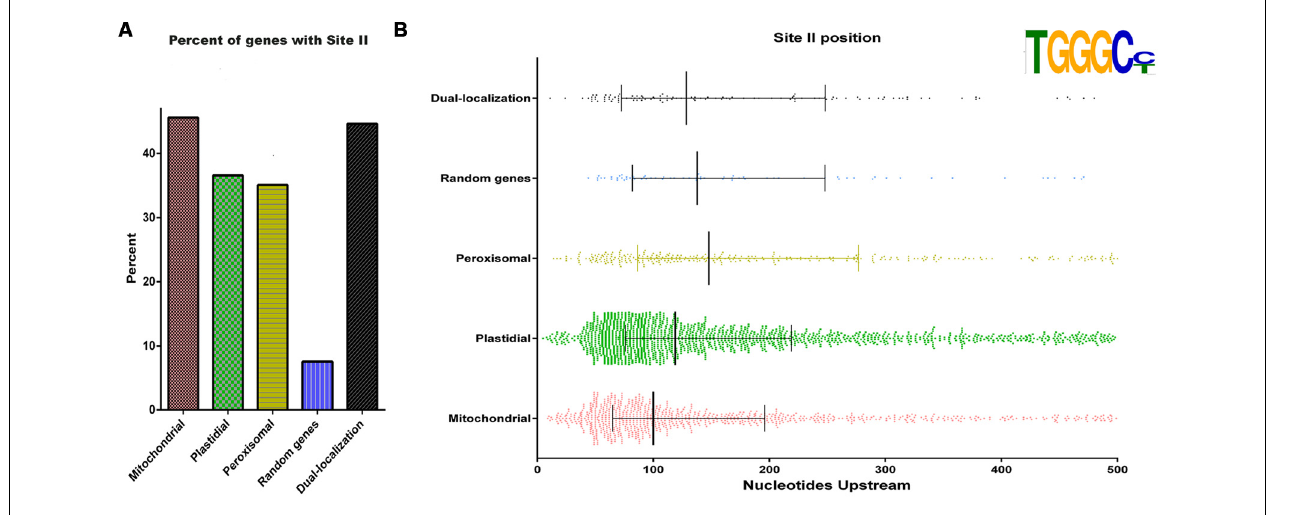
etal. (2012). Dual targeted proteins were taken from Xu etal. (2013b). The term “Random genes” refers to a set of 490 genes picked at random. (B) Location of site II elements respective to the transcription start site in different sets of genes. Vertical lines represent the first, second, and third quartiles,